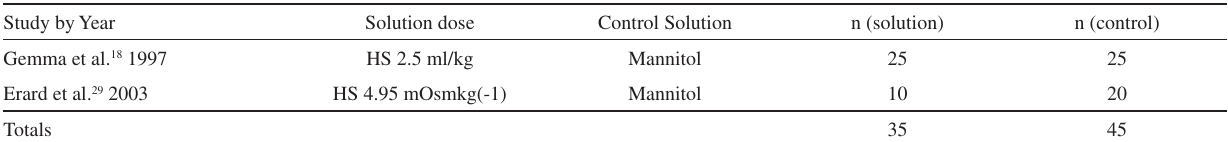
Table 3 - Perioperative studies on the use of hypertonic saline (7.2 -7.5% NaCl) alone or in association with either dextran (HSD) or hydroxielthyl starch (HSS) compared to 20% mannitol or normal saline (NS) in neurosurgery